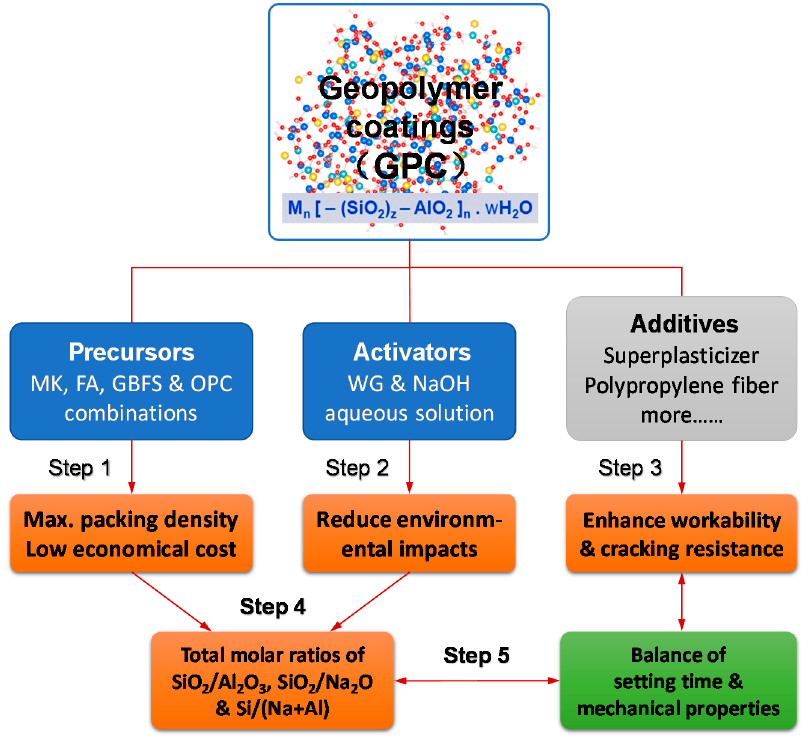
Figure 3. Mixture design procedure of GPC: a step by step methodology of mixture formulation involving particle packing, environmental impacts, engineering performance, as well as material chemistry.